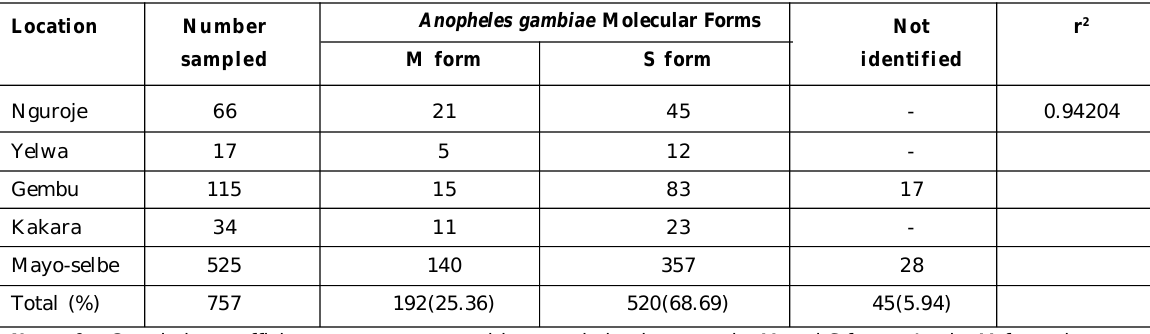
Table 5: Molecular forms of An. gambiae s.s. along altitudinal locations